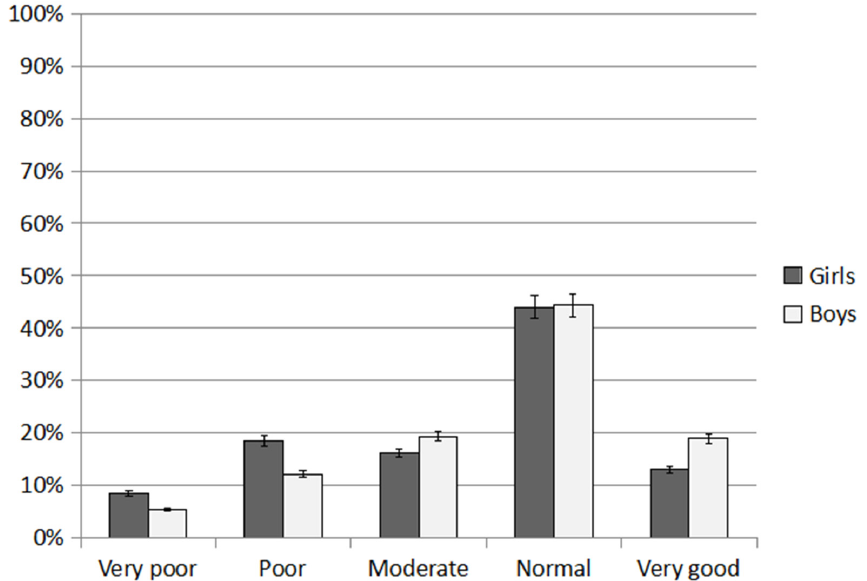
Figure 6. General physical fitness of girls and boys, an average of all fitness test results.